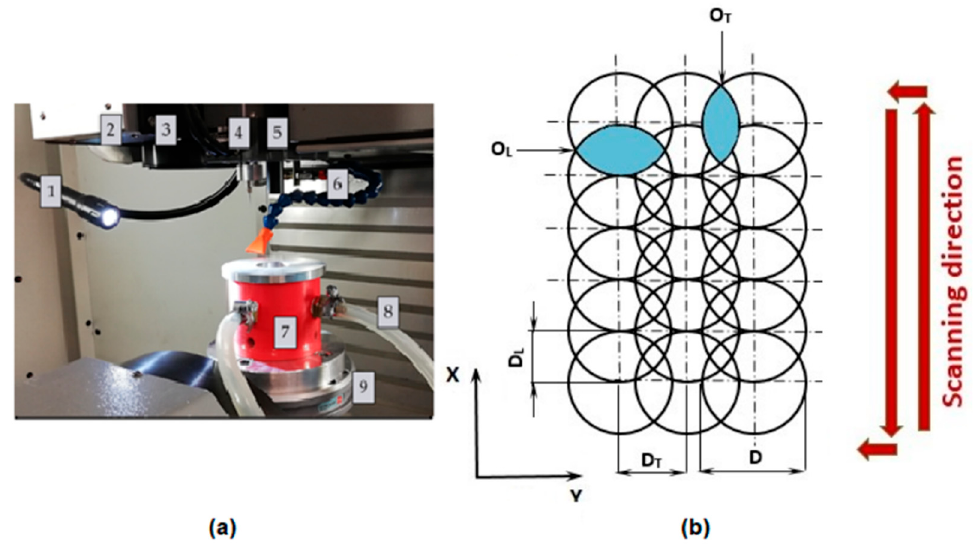
Figure 17. Experiment initiation. ( a ) The primary components of a laser system: a pulse mode design, Illuminating the workstation, first 2—exhaust, 3—output from a laser scanning, the Z-axis measurement probe, Setting the CCD camera, the chiller, the attachment for placing samples, ( b ) the shielding gas input, the work surface, and the laser beam width DT—transverse pulse distance (m), OT—transverse pulse overlap, OL—lateral pulse distance (m), and DL—lateral pulse overlap. Reprinted with permission from [125]. Copyright 2021 MDPI. Distributed under Creative Commons Attribution-based license (CCBY 4.0.).